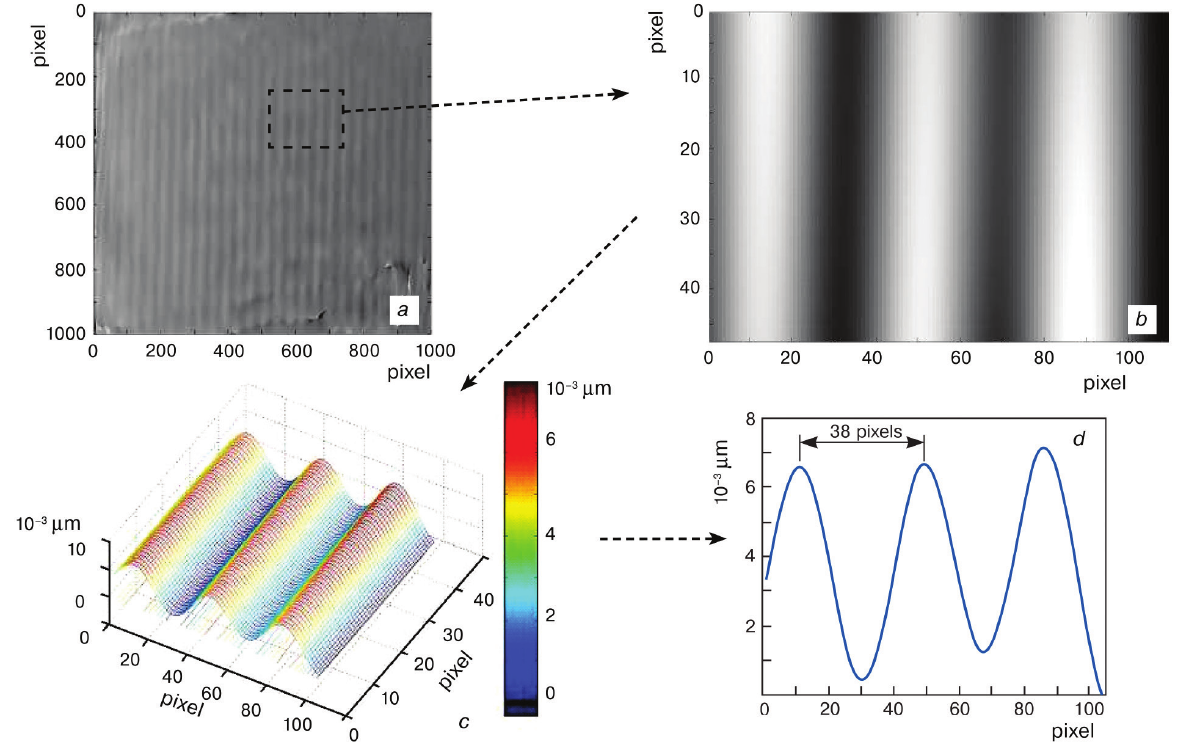
Figure 5. SAW parameters measured in specimen center for excitation by IDT D1 at 17 MHz and in SC mode: ( a ) interference pattern, ( b ) digital magnification of selected area in the interference pattern ( a ); ( c ) restored motion field and ( d ) vertical section of motion field in wave vector direction. Magnification 1.5× (pixel size 6 µm). SAW length: 38 pixels × 6 µm = 240 µm, SAW amplitude: 3–3.5 nm.